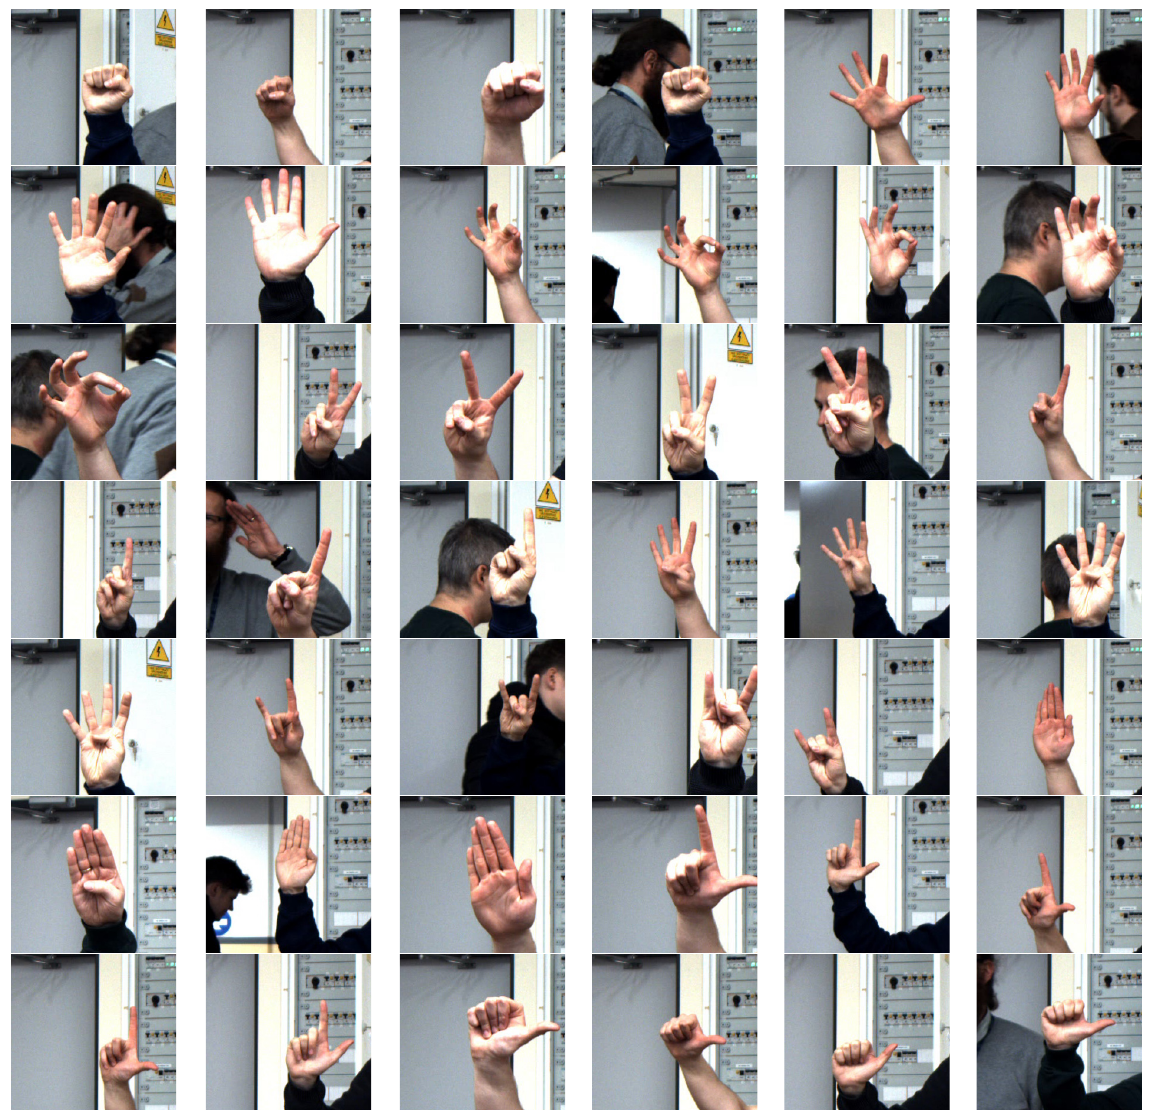
Figure 3. 2D sample images of gestures from left to right: Fist(0), Palm(1), Rabbit(2), Victoria(3), One(4), Four(5), Rock(6), Stop(7), Loser(8), Thumbleft(9).